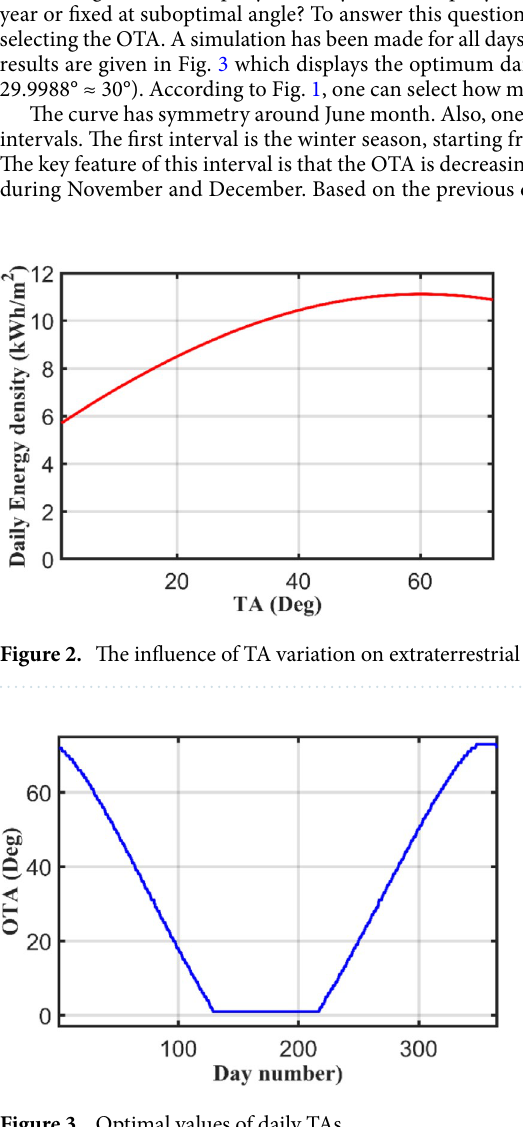
Figure 3. Optimal values of daily